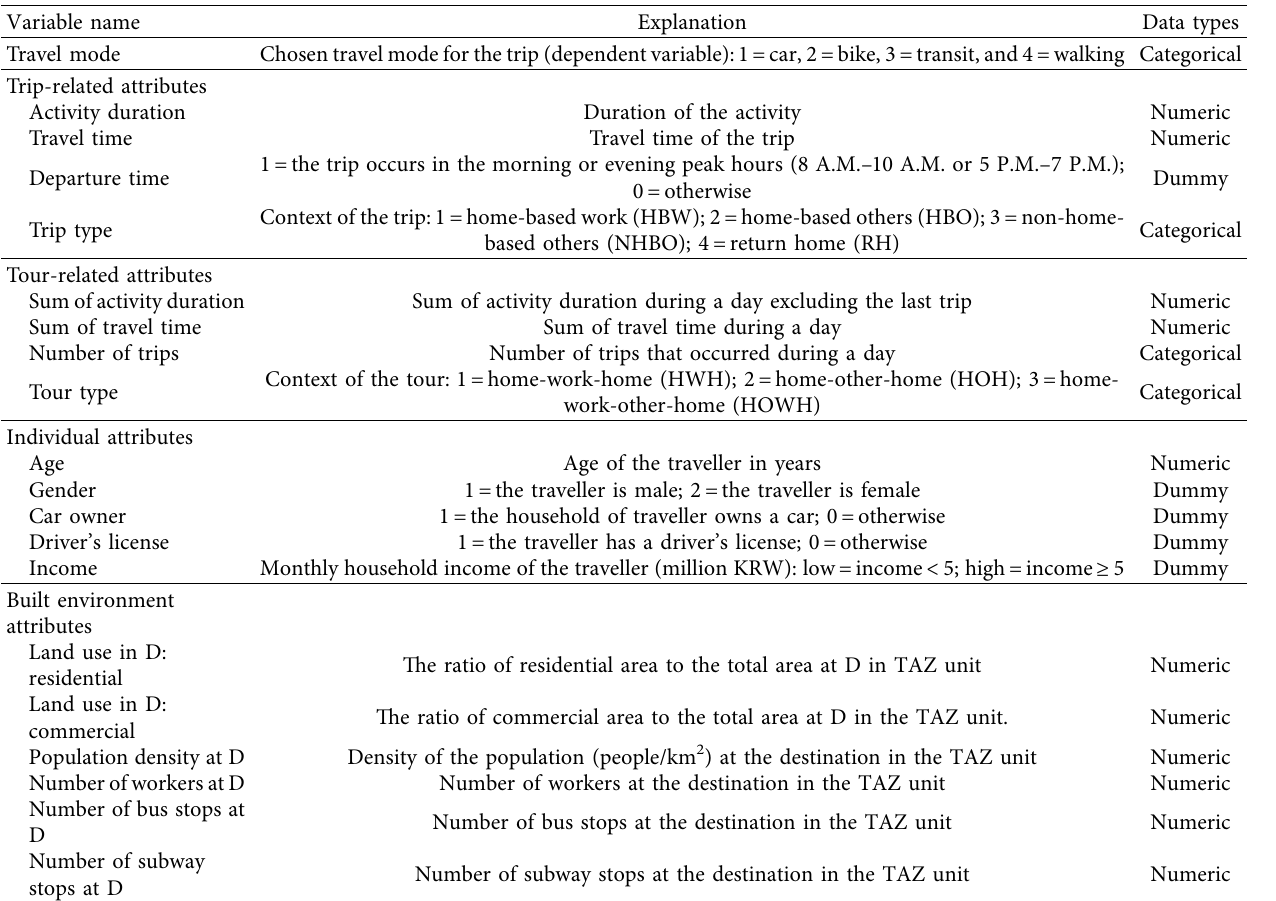
Table 1: Description of the independent and dependent